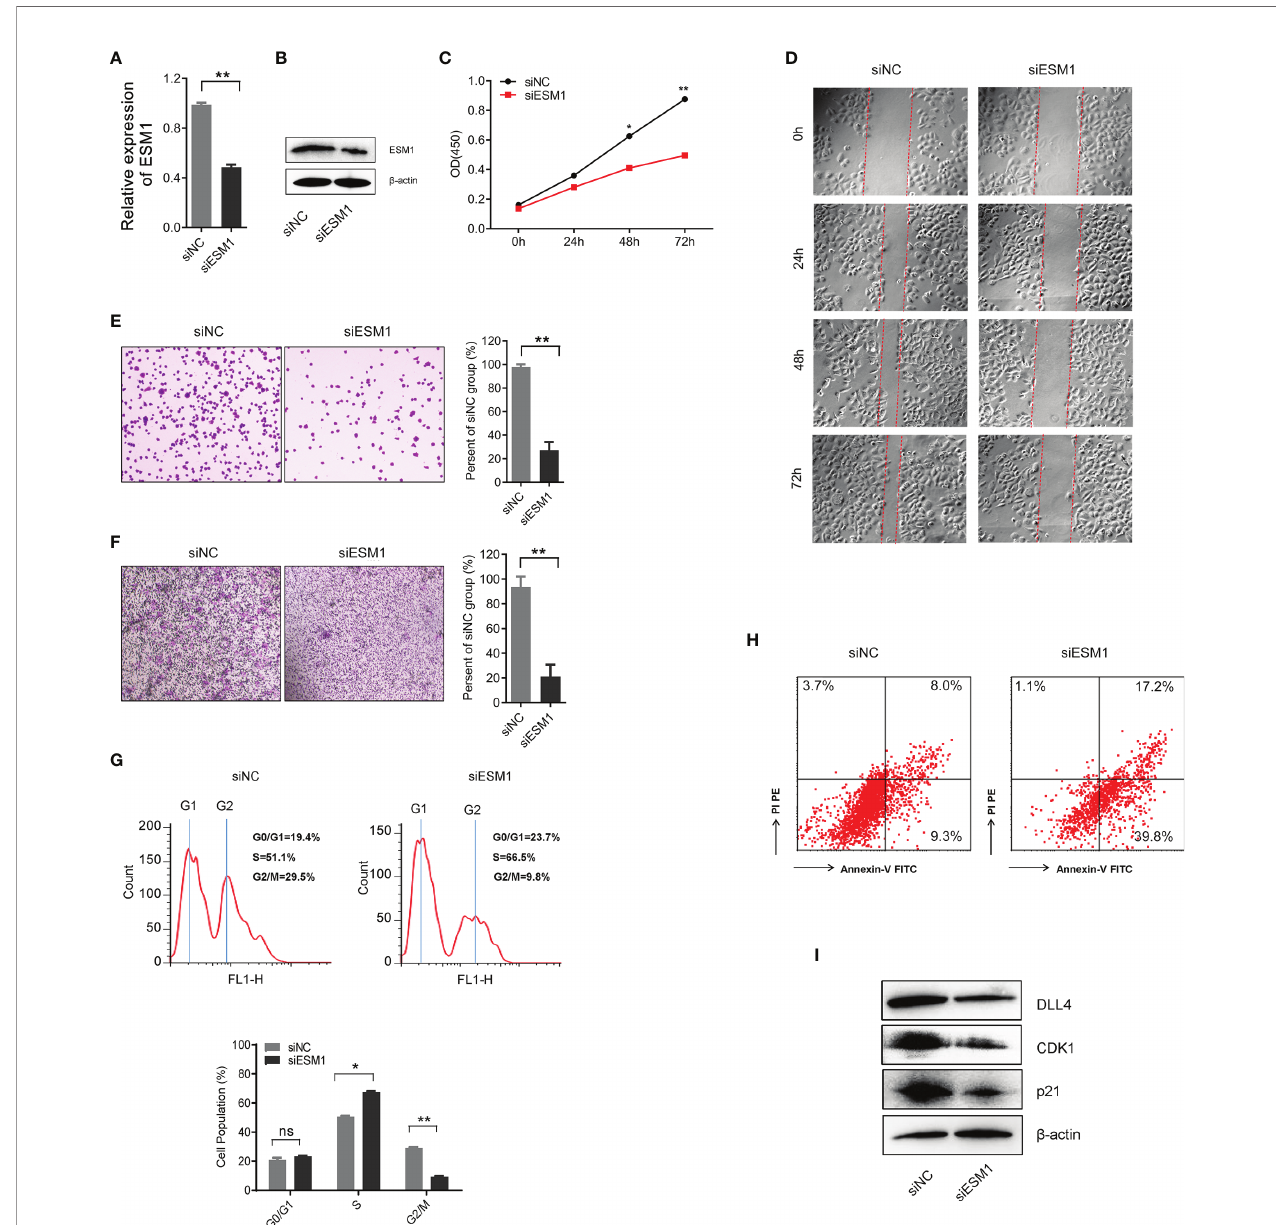
FIGURE 7 | ESM1 might be involved in cell proliferation, cell migration, cell cycle, and cell apoptosis in human SW13 cells. Detection method by (A) the qRT-PCR and (B) Western blotting for ESM1 expression in human SW13 cells after transfected with siESM1 or siNC for 72 h. (C) Cell proliferation assay for human SW13 cells after cells were transfected with siESM1 or siNC for 72 h. (D) Wound-healing experiment for cell mobility investigation. The red line denotes the migration ability of SW13 cells transfected with siESM1 or siNC for 48 hours. (E) Cell adhesion assay of SW13 cells transfected with siESM1or siNC for 48 h. (F) Cell invasion assay of SW13 cells transfected with siESM1 or siNC for 48 h. (G) Cell cycle analysis and (H) apoptosis of SW13 cells transfected with siESM1 or siNC for 48 h. (I) Western blotting for DLL4, CDK1, and p21 in human SW13 cells transfected with siESM1 or siNC for 48 h. ns denotes no signi fi cant difference, * p < 0.05, ** p <